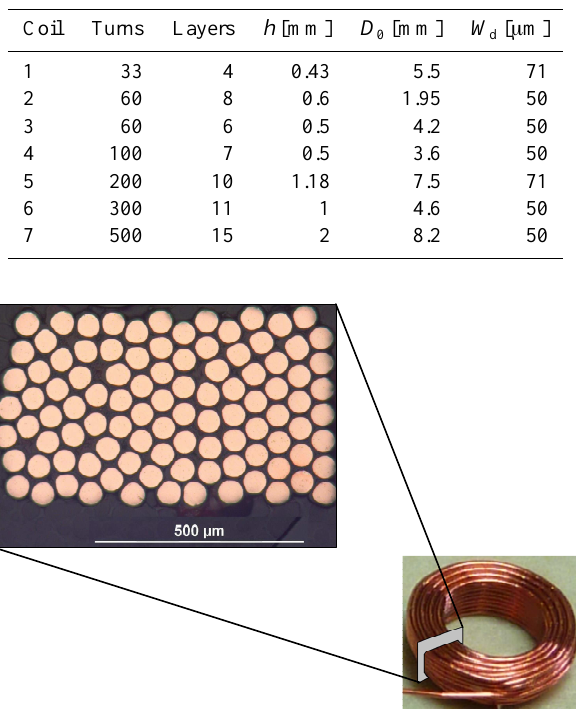
Table 1. Micro coil geometrical data, Fa. Hopt GmbH.